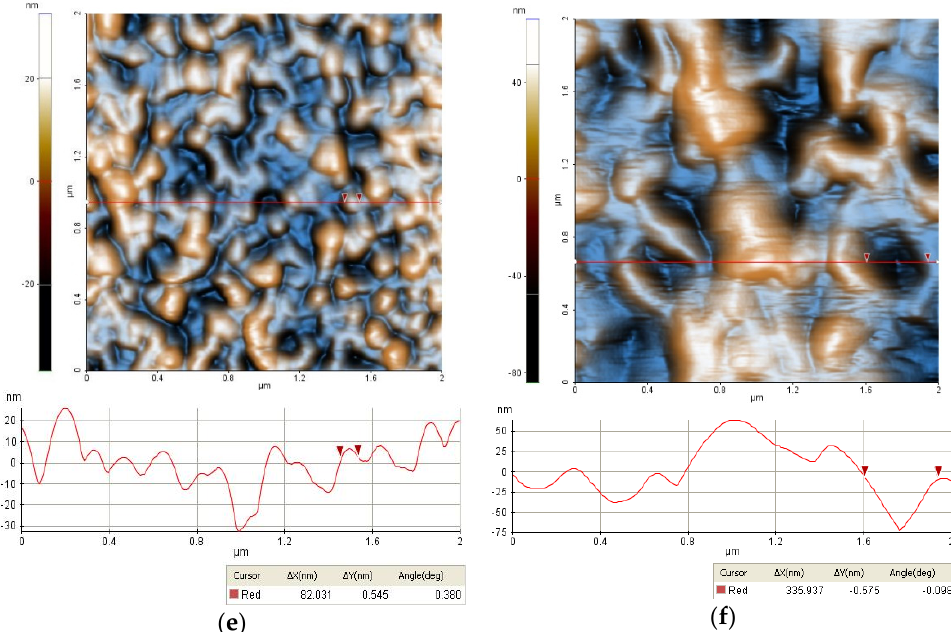
Figure 2. Bidimensional 2D AFM images (presented in enhanced-contrast view mode) together with characteristic line scans recorded from each image at the position indicated in each figure of ( a ) M0 membrane; ( b ) M1 membrane; ( c ) M1-L5 membrane; ( d ) M1-L10 membrane; ( e ) M2-L5 membrane; and ( f ) M3-L5 membrane.